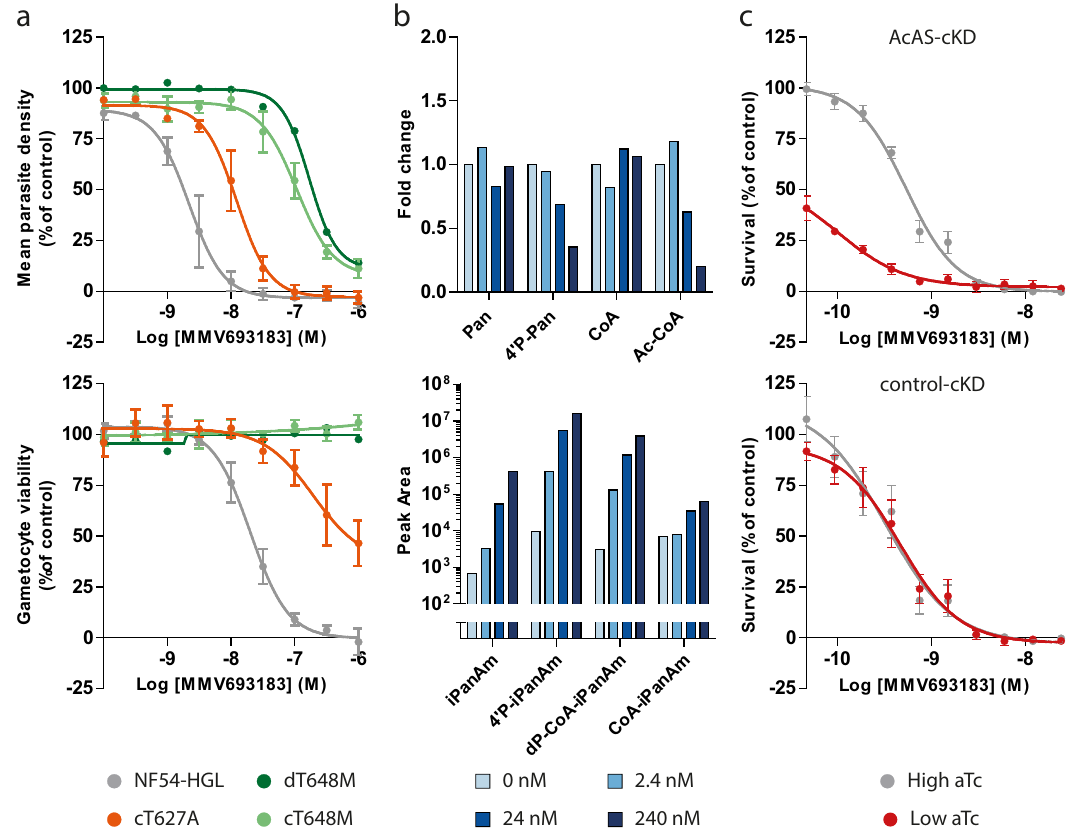
Fig. 2 Role of AcAS in the mode of action of MMV693183. a Drug-sensitivity pro fi les with asexual (upper panel) or sexual (lower panel) blood-stage parasites without a mutation (NF54-HGL) or with a T648M or T627A mutation in AcAS. An MMV693183-selected resistant parasite line (dT648M) was tested in one experiment with two technical replicates and the CRISPR-engineered parasites (cT648M and cT627A) were tested in three independent experiments (two technical replicates per experiment). The average value for mean parasite density relative to controls ± SEM are shown. b